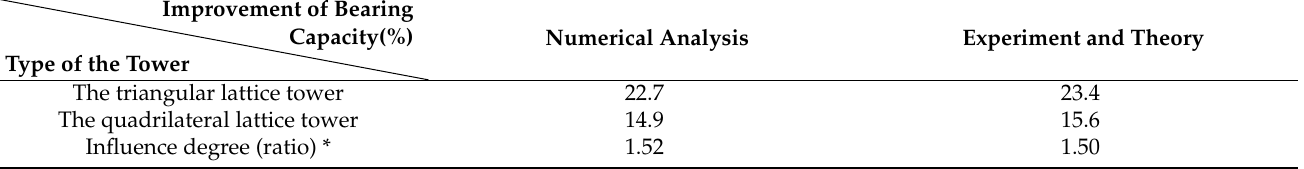
Table 2. Influence of the DLDPJ on stability bearing